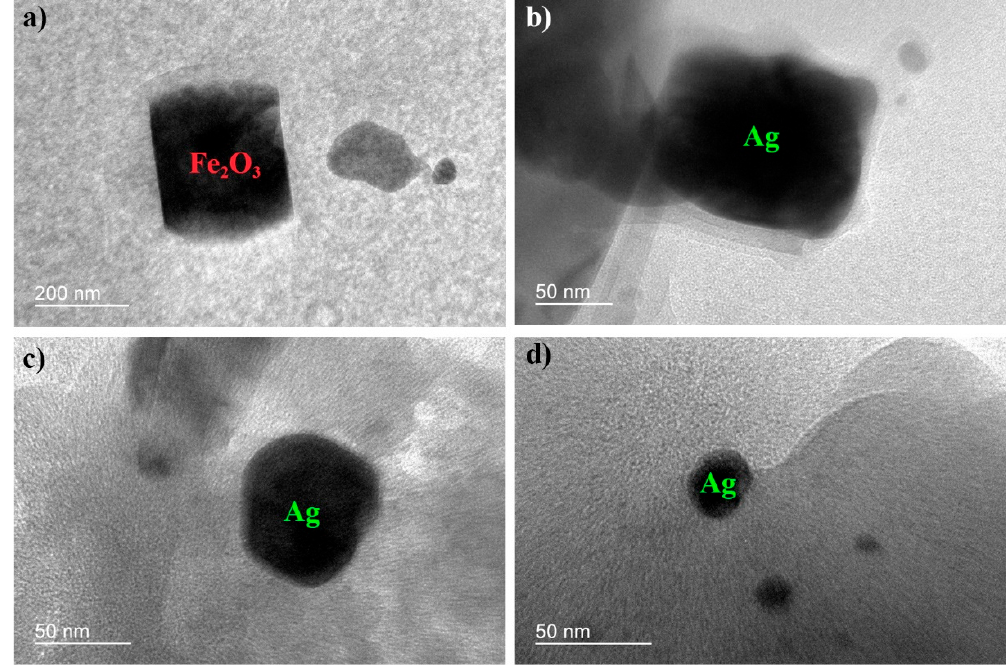
Figure 6. TEM images of Ag-Fe 2 O 3 @CA; ( a ): Fe 2 O 3 nanoparticle; ( b , c,d ): Ag nanoparticles of various sizes.